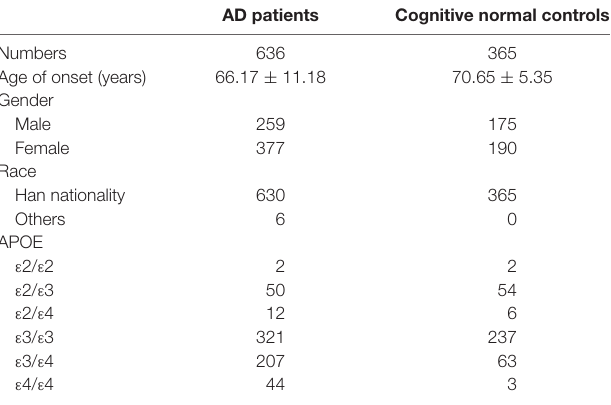
TABLE 1 | Basic information of patients and controls. AD